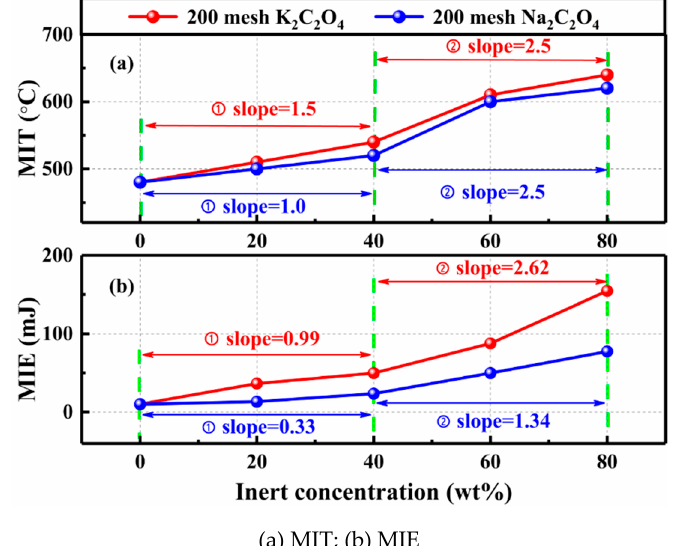
Figure 10. Effect of Na 2 C 2 O 4 and K 2 C 2 O 4 powder concentrations on the MIT and MIE of PE. Figure 10. E ff ect of Na 2 C 2 O 4 and K 2 C 2 O 4 powder concentrations on the MIT and MIE of